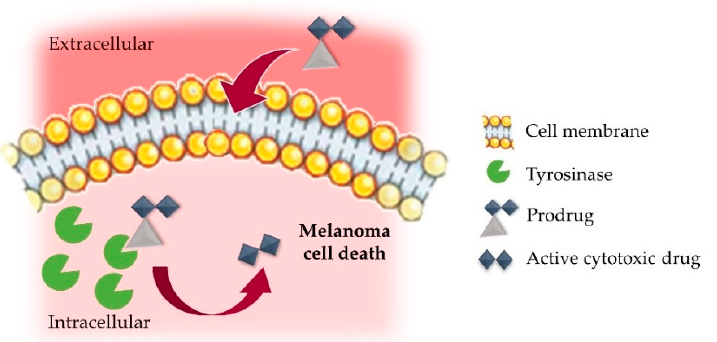
Figure 3. Schematic representation of tyrosinase-mediated prodrug release in a melanoma cell. Adapted from [28], with permission from Elsevier,